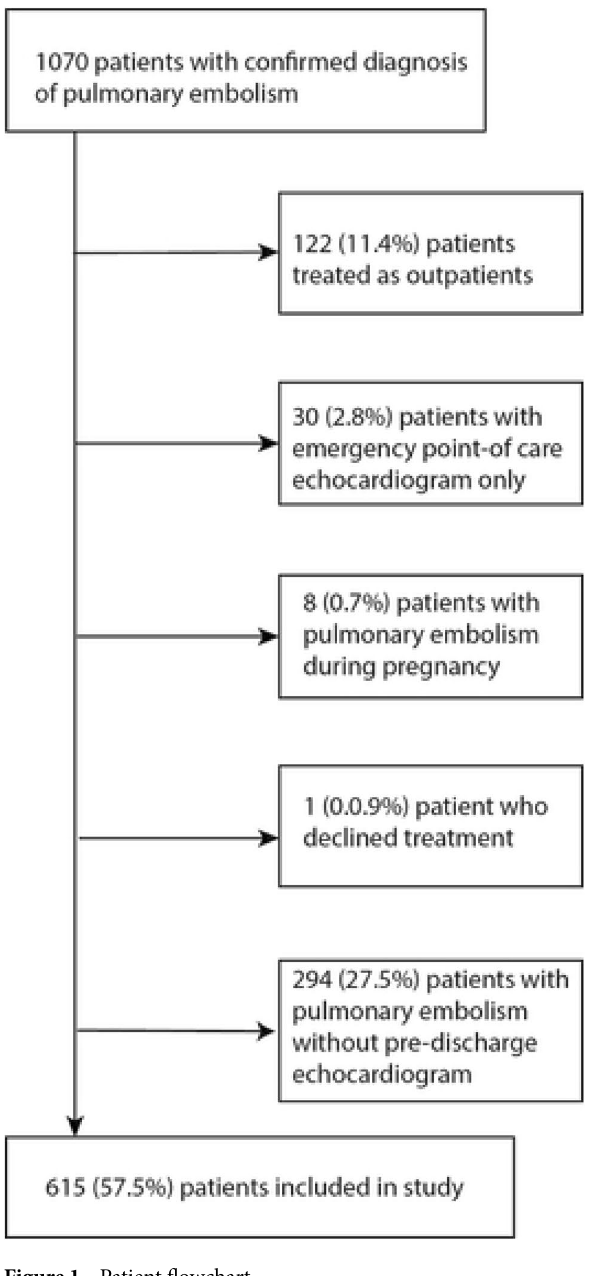
Figure 1. Patient